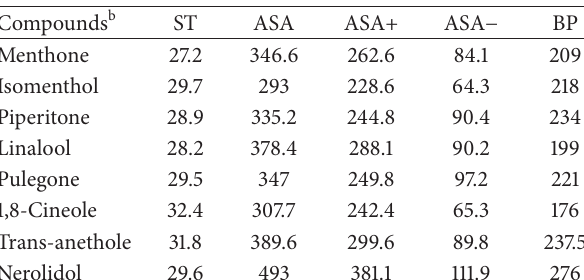
Table 6: Calculated molecular descriptors a for compounds used in QSAR analysis of the insecticidal activity on triatominae